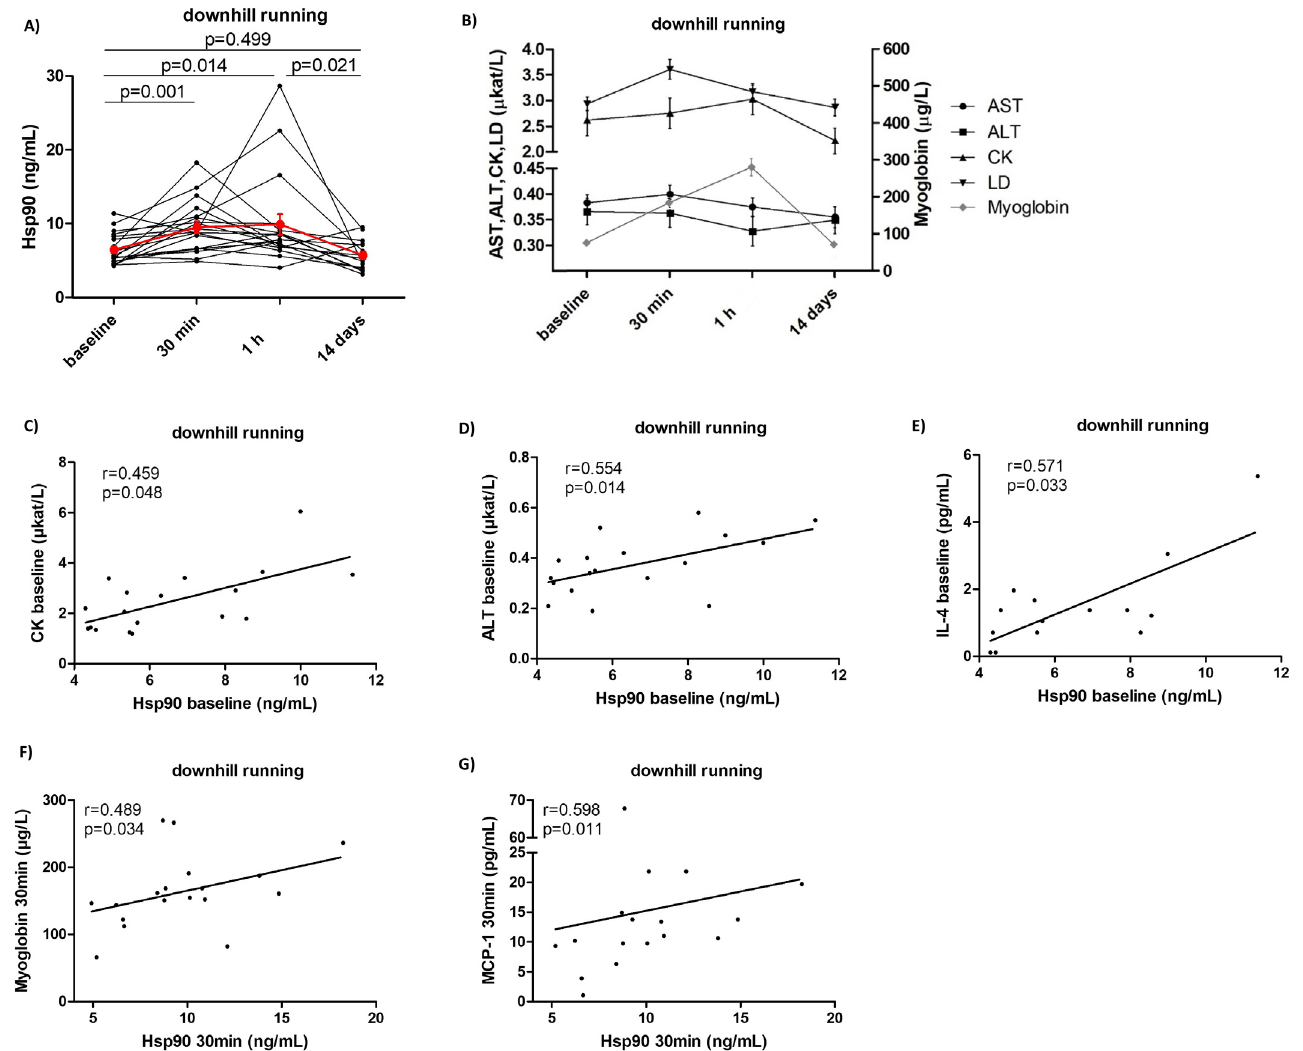
Figure 3. Systemic levels of Hsp90 and selected traditional markers of muscle damage and inflam- mation in healthy volunteers ( n = 18) upon strenuous exercise. Systemic levels of Hsp90 ( A ) and of AST, ALT, CK, LD, and myoglobin ( B ) from baseline to 14 days after the intervention. Baseline plasma Hsp90 levels correlated positively with baseline serum levels of CK ( C ), ALT ( D ), and IL-4 ( E ). Plasma Hsp90 levels at 30 min correlated positively with serum levels of myoglobin ( F ) and MCP-1 ( G ) at 30 min. The red line ( A ) and the black/gray lines ( B ) represent the mean and the whiskers ( A , B ) represent the standard error of the mean.